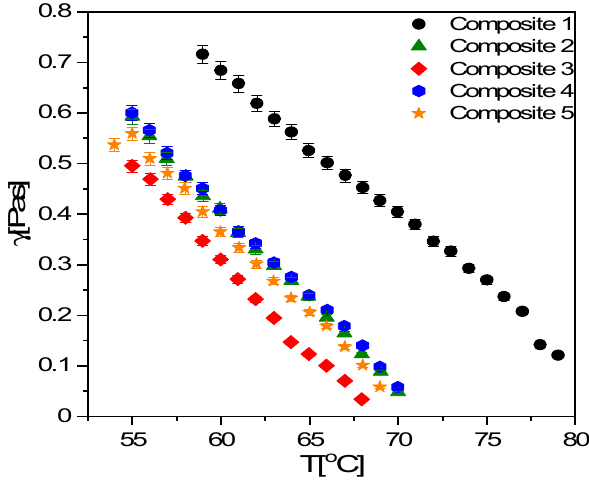
Figure 13. Temperature dependence of the rotational viscosity for Composites 1–5. The area of electrodes in the ITO cell used is 5 × 5 mm 2 . The width and the length of the LC molecule are ca. 5 Å and 40 Å [77] respectively, while the thickness of the smectic layer is about 37 Å (in tilted SmC* phase, tilt angle of 20°). Then, the electrode surface will cover about (5 mm/5 Å) × (5 mm/37 Å) = 1.35 × 10 13 LC molecules, while about (4.9 μ m/5 Å) × 1.35 × 10 13 = 1.323 × 10 17 LC molecules will be present in the volume of the electrodes (4.9 μ m—thickness of the ITO planar cell). As it is known, the nanoparticle used is about 12.5 times larger than the liquid crystal molecule (the length of LC molecules L ≈ 40 Å, the nanoparticle size d ≈ 50 nm, d/L ≈ 12.5). Therefore, one nanoparticle occupies the volume of 14 LC molecules in one dimension in a single smectic layer of tilted phase (SmC*, θ ≈ 20°), and 14 × 14 × 14 = 2744 LC molecules in three dimensions. We used a very low concentration of nanoparticles for the synthesis of nanocomposites. If 1.323 × 10 17 LC molecules will be present in the volume of the electrodes for pure EHPDB, 1.319 × 10 17 LC molecules and 9.628 × 10 9 nanoparticles will be present for Composite 2 (0.3 wt.%). Thus, the admixture of nanoparticles at such a low concentration eliminates a negligibly small amount of LC molecules and could not be responsible for the significant decrease of spon- taneous polarization, tilt angle and rotational viscosity (if the P s of Composite 3 is practi- cally half of pure EHPDB, the introduced nanoparticles should eliminate half of the LC molecules). The FTIR results do not show that there is a chemical bond between nanopar- ticles and LC molecules (see below), however strong physical adsorption of molecules to the surface of nanoparticles cannot be ruled out. Besides, in the vicinity of the nanoparti- cle, the packing of LC molecules can be completely different than in the volume in which there are no nanoparticles. Figure 14 schematically shows the effect of increasing the concentration of nanopar- ticles on the arrangement of molecules in a thin layer of composites in measuring the ITO cell. It should be stressed that the drawing is not to scale, i.e., the individual nanoparticle is larger than the liquid crystal molecule. In turn, Vimal et al., by doping ferroelectric liq- uid crystal Felix 17/100 with ferromagnetic nanoparticles (ZnO:Cu 2+ ions, 1 wt.%), ob- tained the enhanced spontaneous polarization due to magneto-electric coupling [78]. To summarize, to explain the decrease in electrical parameters, further research is needed,